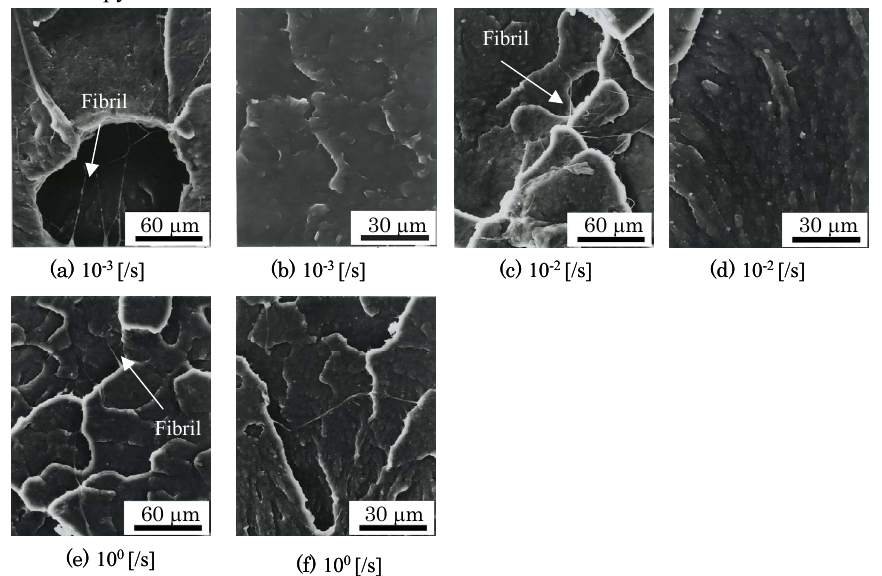
Figure 5 Fracture surface of 70ºC-24h specimens observed by scanning electron